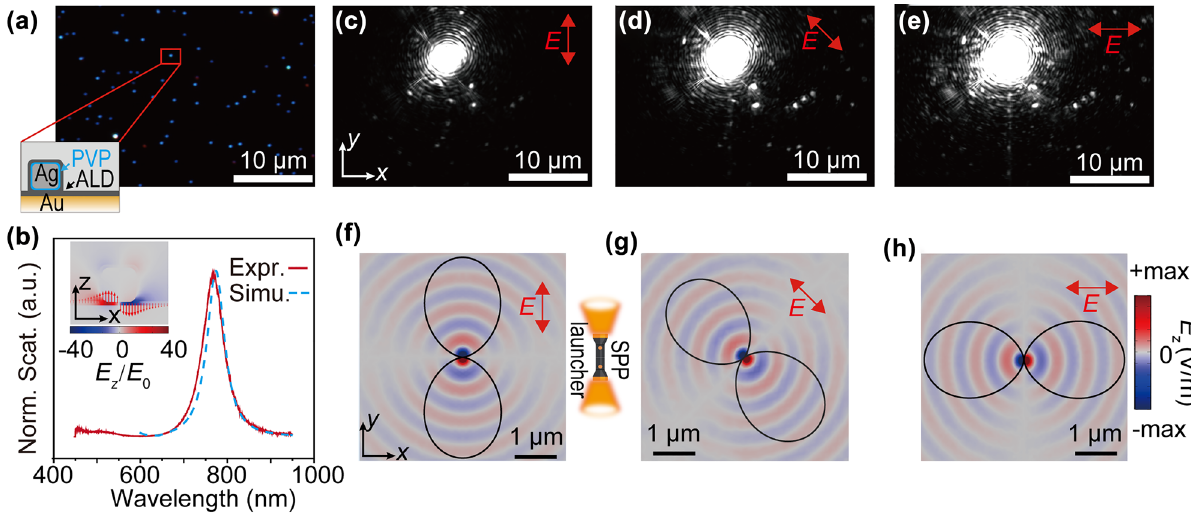
Figure 2: SPPs traveling between NCoM pairs and remotely lightening the transmitting antennas. Dark-field image (a) and scattering spectrum (b) of the NCoMs. The inset of (b) shows the local field in the NCoM cavity. (c–e) are the images of NCoM excited by the laser on resonance (770 nm). Many NCoMs far away from the laser show bright emissions, revealing that they were excited by SPPs. (f–h) are the field of the SPPs propagating on the surface launched by the NCoM, with different E- polarization. Black curves are the far-field simulated E z diagram of the